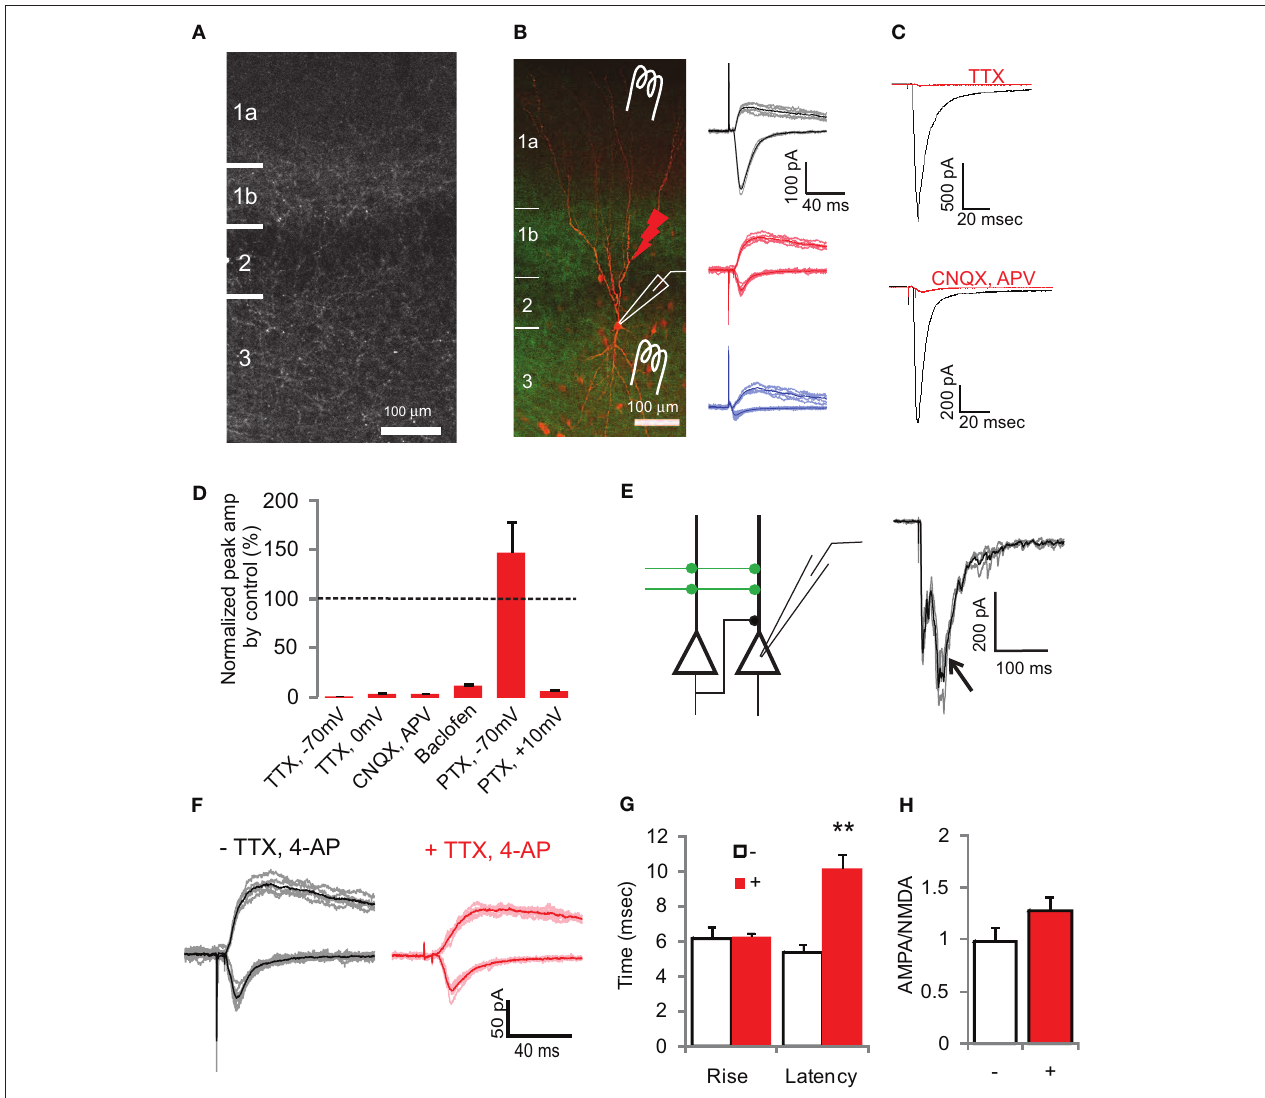
FIGURE 2 | Light-evoked EPSCs at AON to aPC synapses. (A) ChR2-EYFP expressing axon fibers from the AON projecting to the aPC with AAV injection into the AON of a rat pup (P6). Fluorescence intensity was high in layer 1b where most of the associational fibers are found, but there were also labeled fibers in layer 2/3 and layer 1a. (B) A recorded pyramidal cell was visualized using biocytin, with its soma in layer 2, and apical and basal dendrites in layer 1 and layer 3 respectively (left). The green signal is from ChR2-EYFP positive axon fibers from the AON. Other red somata result from background staining due to dye leakage from patch pipettes. Schematic of a pyramidal cell with three different ways of stimulation and examples of synaptic responses. LOT and associational fibers were electrically stimulated with a concentric bipolar electrode placed in the LOT or layer 2/3 respectively. ChR2 positive axon fibers from AON were activated by a 5ms blue LED flash using a 40 × objective lens. Traces show examples of synaptic responses from the different stimulation protocols (right): LOT electrode (black), associational electrode (blue), and associational LED (red). EPSCs were detected as inward currents at − 70mV and outward currents at + 40mV. Traces are the superposition of five individual trials as well as the average response (thick lines). ACSF contained picrotoxin (PTX) to block inhibitory currents. (C) Inward current recordings from a pyramidal cell at − 70mV evoked with 5ms blue LED light stimulation without any drugs (black traces). Application of a